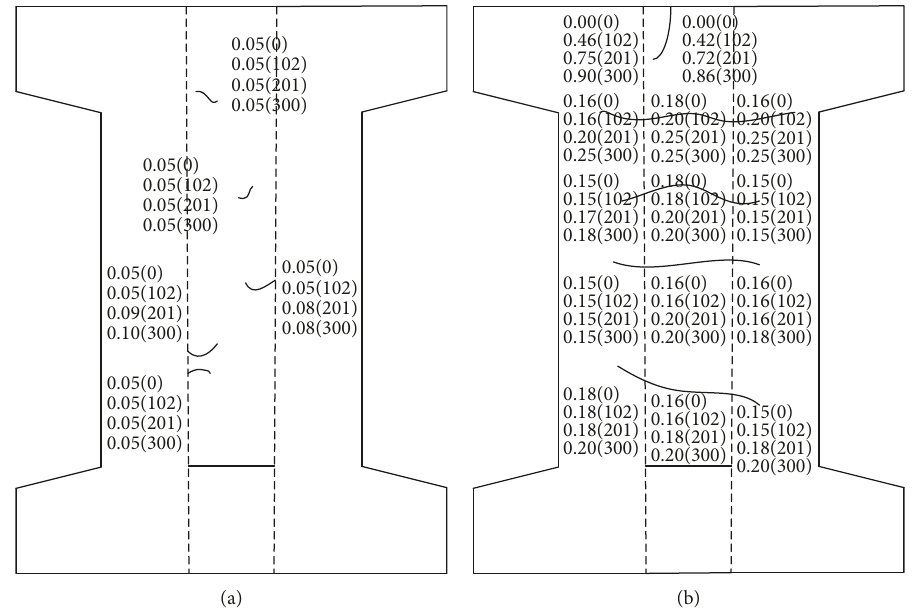
Figure 5: Initial cracks in Col-3 (a) and Col-4 (b) induced by eccentric compressive load and their development due to freeze-thaw cycles and seawater